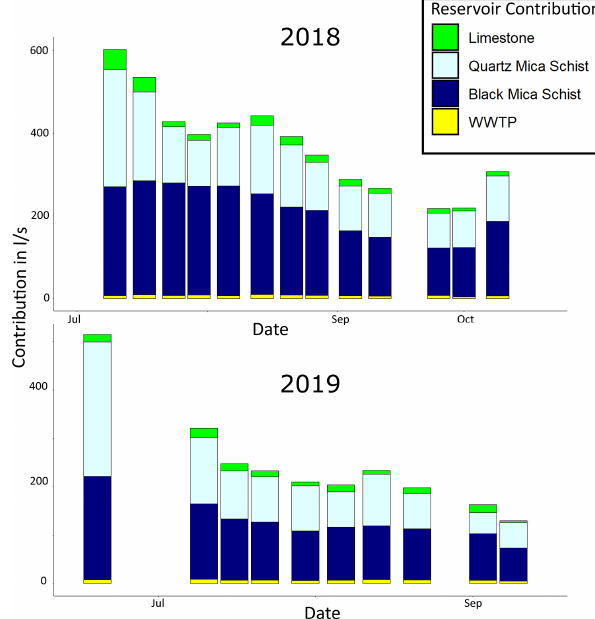
Figure 10. Evolution of the contribution of the various reservoirs during the summers of 2018 and 2019. The difference in the num- ber of samples between 2018 and 2019 is due to the differences in sampling frequency between the two years, weekly and fortnightly for 2018 and for 2019 respectively. The uncertainty associated with these proportions is less than 15% for WWTP and limestone waters and less than 35% for quartz and black mica schist